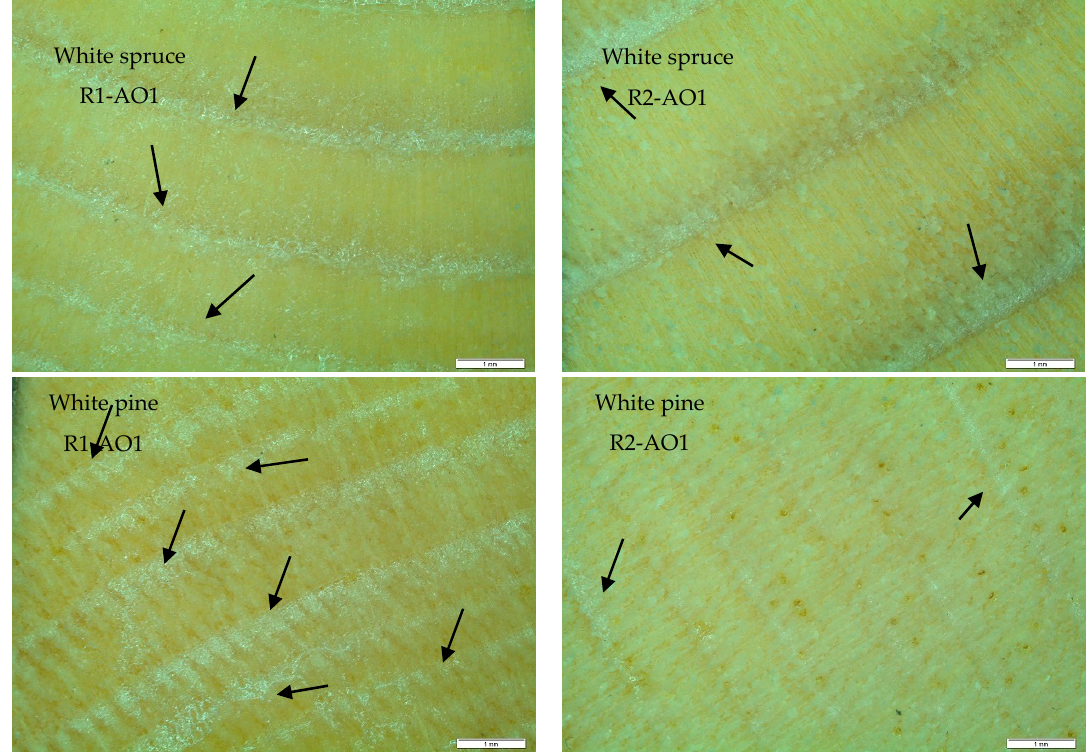
Figure 5. Optical microscopy of the transverse plane of white spruce and white pine treated with R1-AO1 and R2-AO1. The arrows indicate the presence of resin at the surface of the